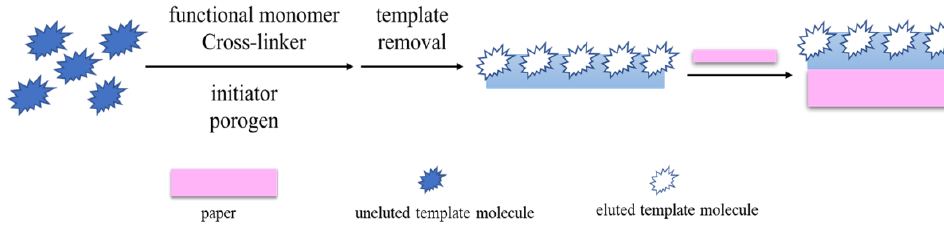
Figure 2. Preparation of MIP-PADs by the post-introduction